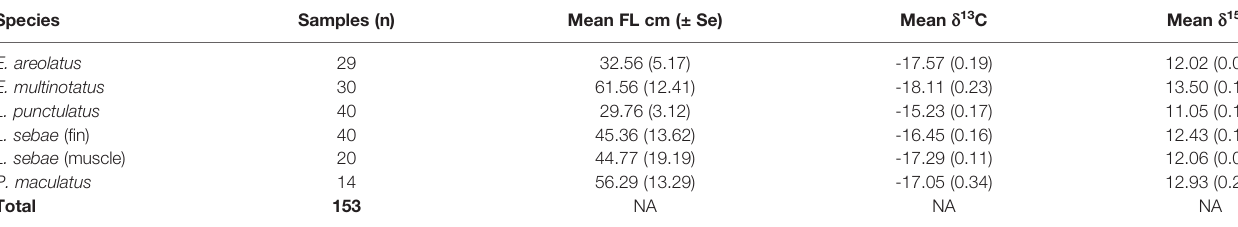
TABLE 1 | Summary of fi n clip samples of predatory fi shes used for stable isotope analyses. Species Samples